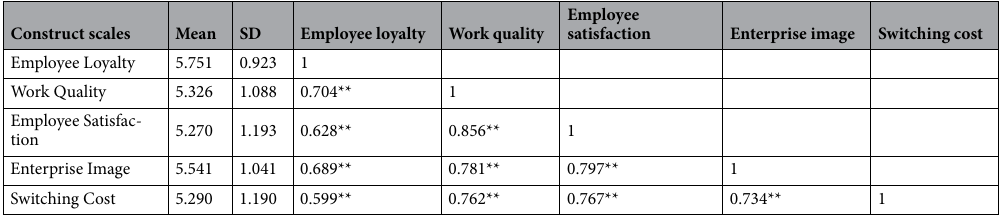
Table 2. Descriptive statistics and correlations among variables. **Correlation is significant at the 0.01 level, N = 440.